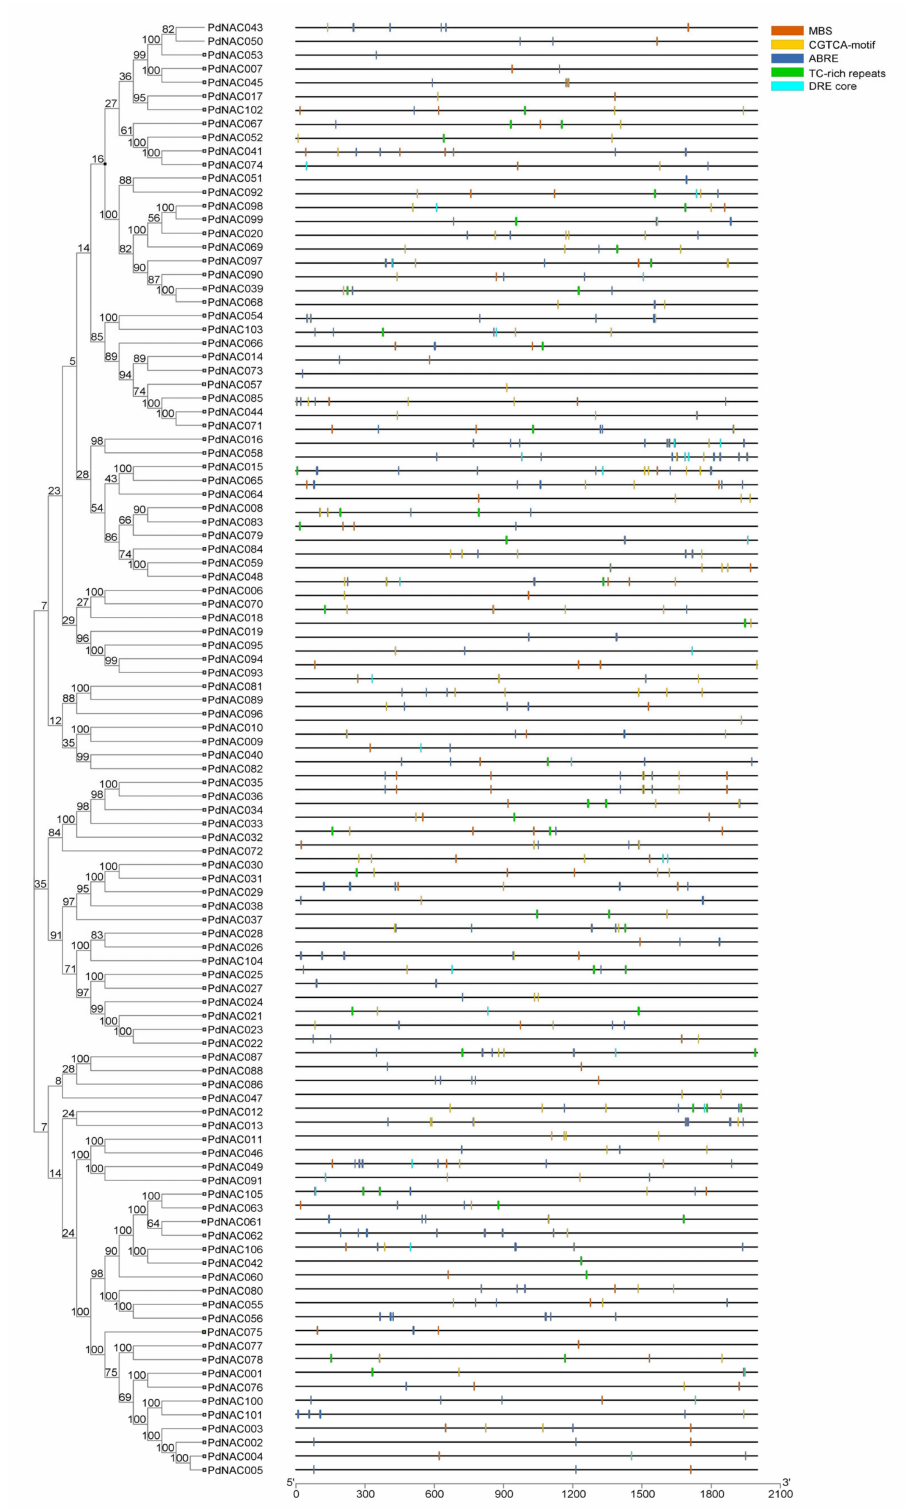
Figure 2. Prediction of cis -regulatory elements of PdNAC . Cis -regulatory elements are shown in upstream region of the PdNAC . Cis -regulatory elements are shown in different